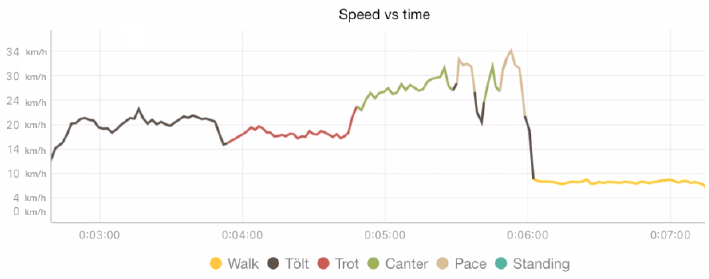
Figure 4. Plot of aggregate judge classifications against time, showing initial unclassified period ( − 1) and three periods of dispute ( − 2). The y -axis corresponds to the chosen label as defined in Table 1.